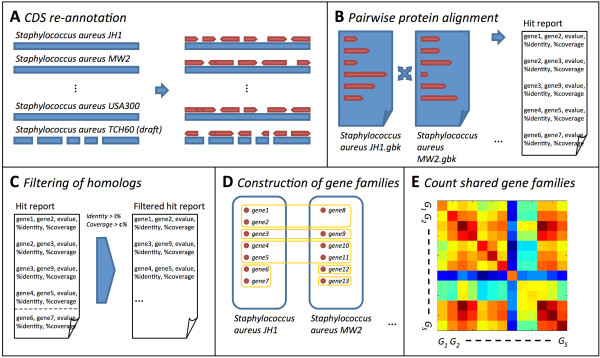
Schematic of bioinformatics fluidity pipeline. (A) Genomes are annotated automatically to minimize curation bias [39]; (B) For a given pair of genomes, all genes are compared using an all vs. all protein alignment; (C) Shared genes are identified based on whether alignment identity and coverage exceed i and c respectively; (D) Gene families are calculated based on a maximal clustering rule; (E) The number of shared genes is found for each pair of genomes, Gi and Gj, from which the number of unique genes can be calculated. Refer to the Methods for complete details of the pipeline and Additional file 1, Table S1 for a complete list of genomes analyzed.